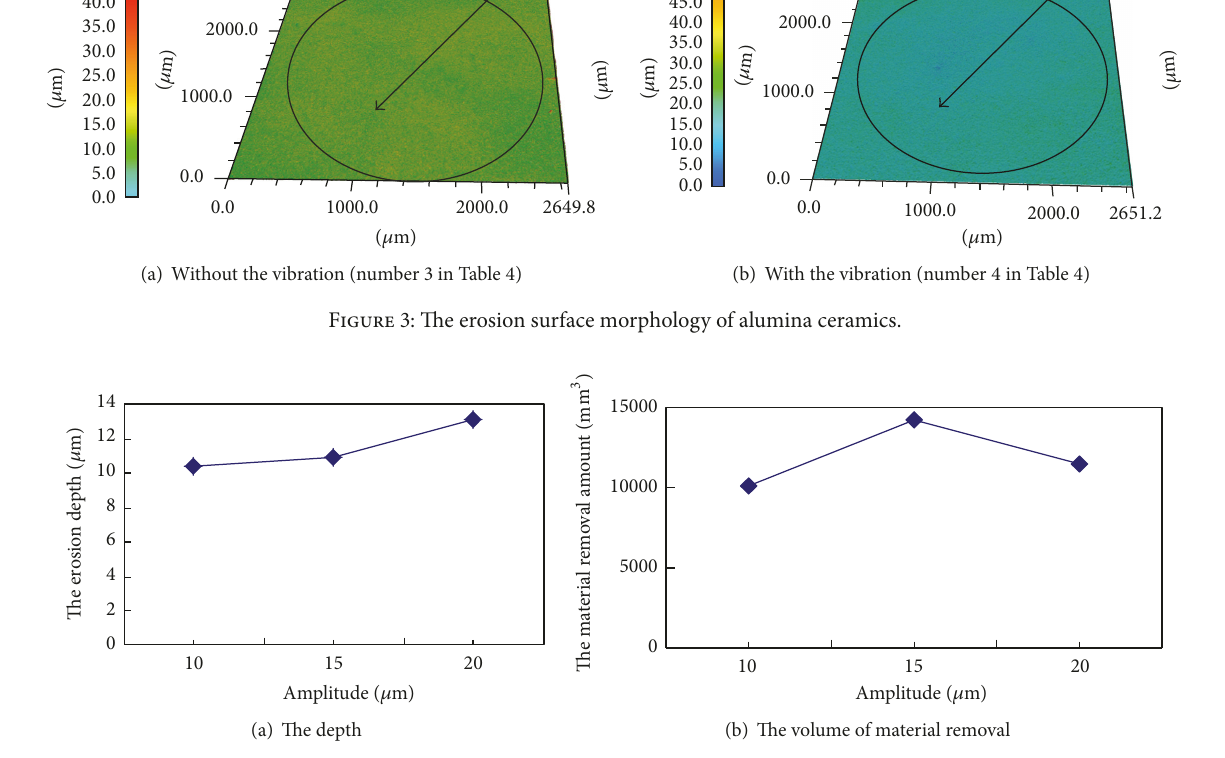
Figure 4: The effect of amplitude on the depth and the material removal amount.